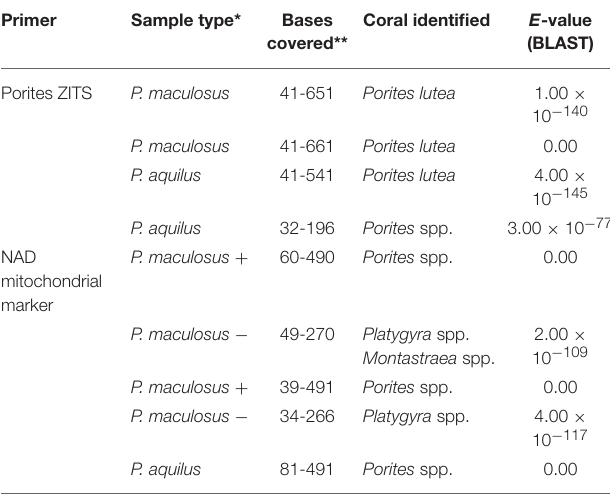
TABLE 3 | Corals identified from Sanger sequencing of two P. maculosus samples and two P. aquilus samples. Primer Sample